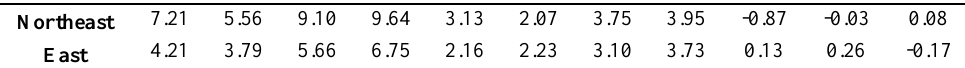
Table 1. Accuracy of geometric error(X: East; Y: North; XY: plane; Z: elevation